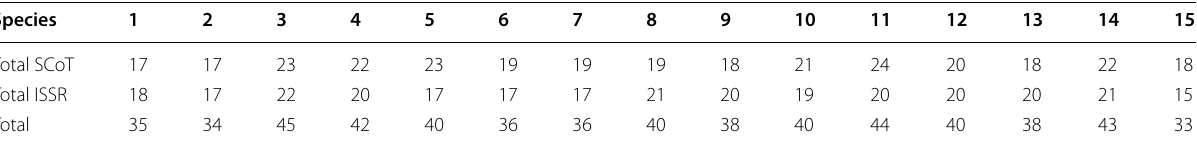
Table 6 Combination of SCoT and ISSR scored bands